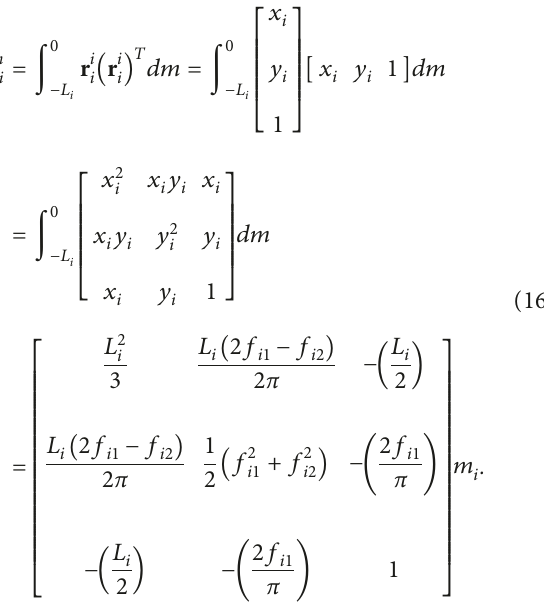
i with different value of μ i